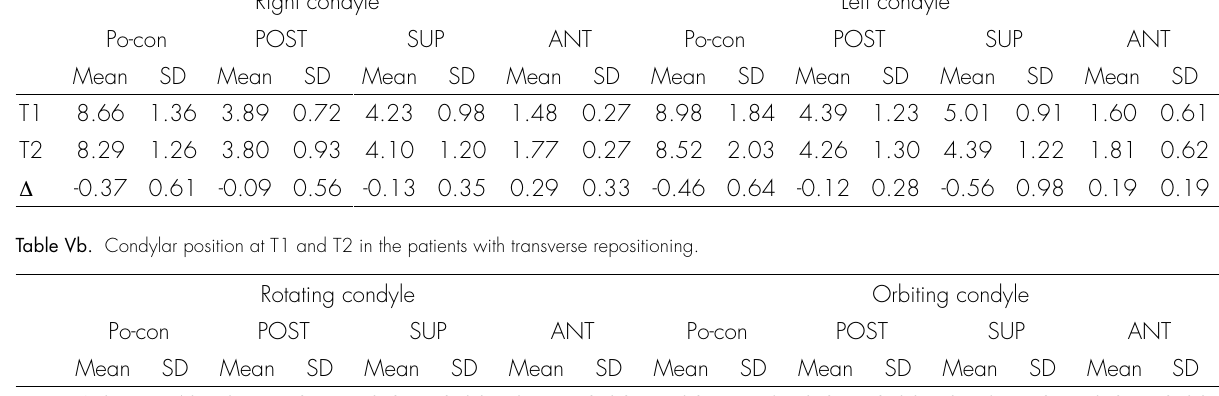
Table Va. Condylar position at T1 and T2 in the patients with sagittal repositioning.